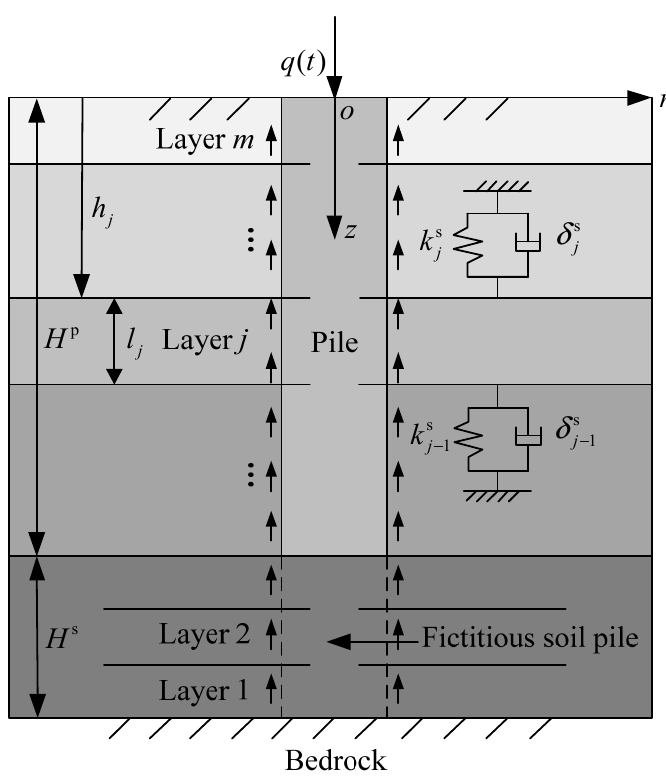
Figure 1. Geometry of the pile–soil interaction model.